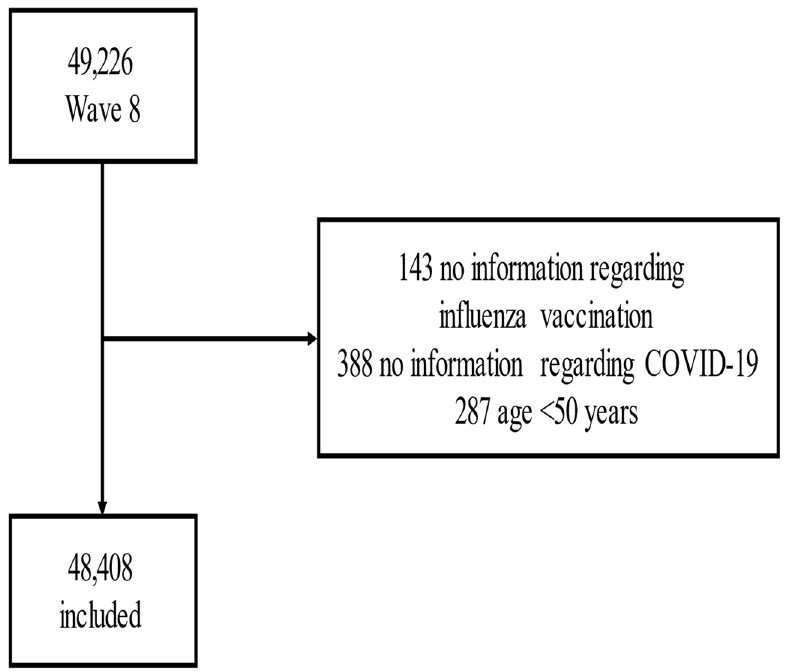
Figure 1. Flow-chart. Table 1. Descriptive characteristics by influenza vaccination or